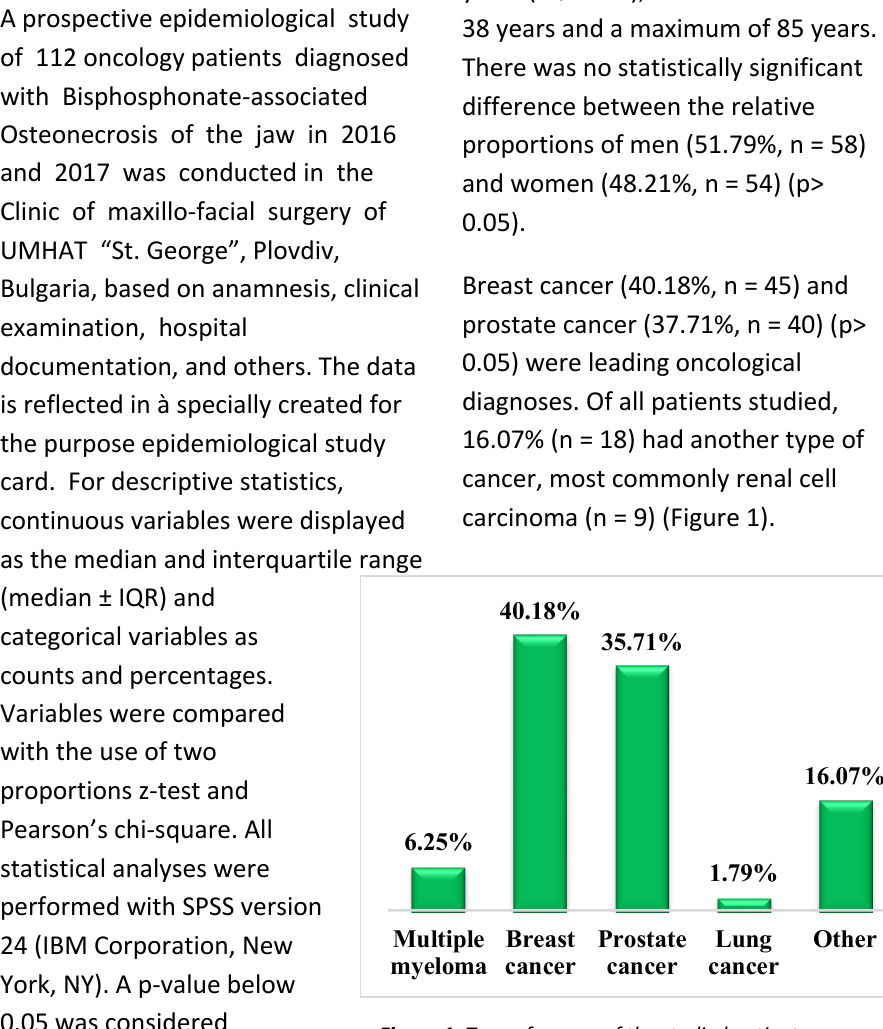
Figure 1. Type of cancer of the studied